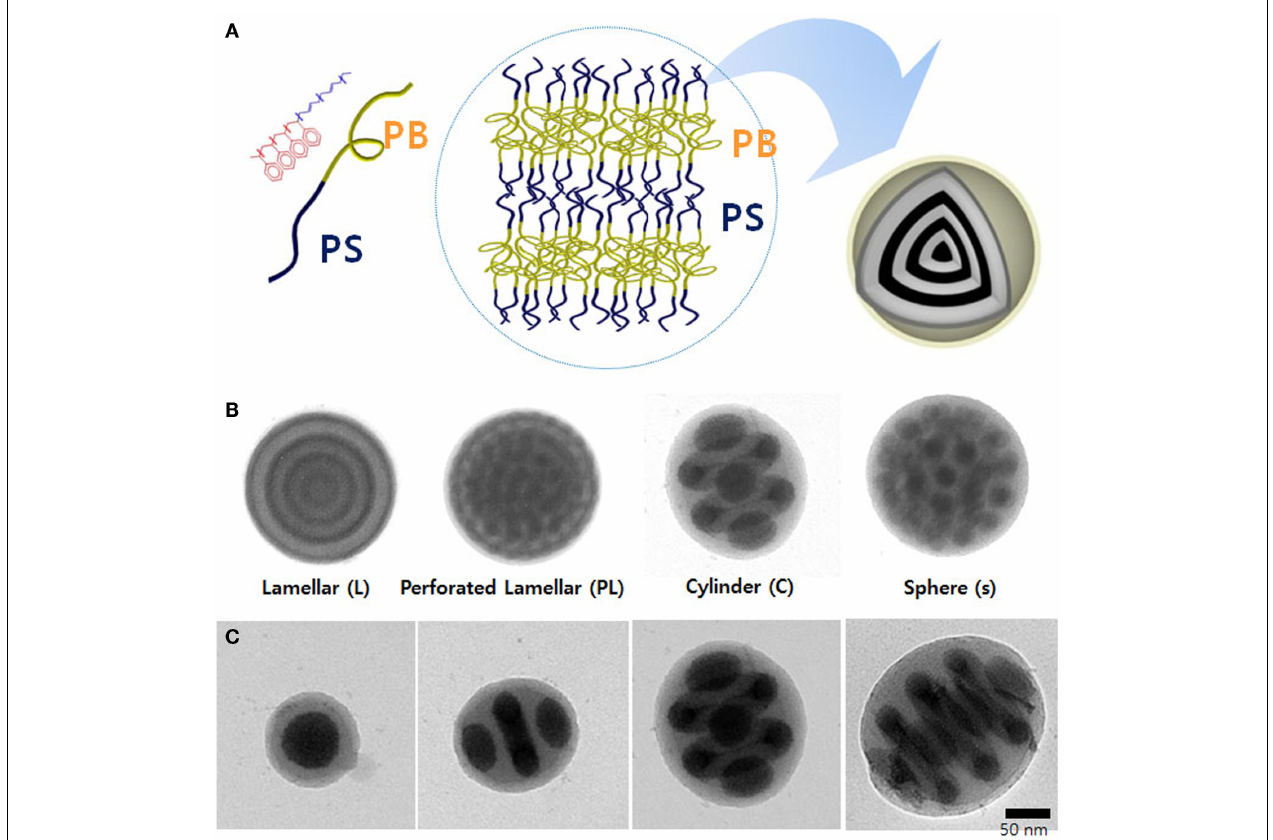
FIGURE 2 | 3D confinement effect of BCPs in emulsion droplet . (A) Schematic illustration of preparation of PS-b-PB BCP particles with nanostructures in emulsion droplets. Morphological transition of the BCP